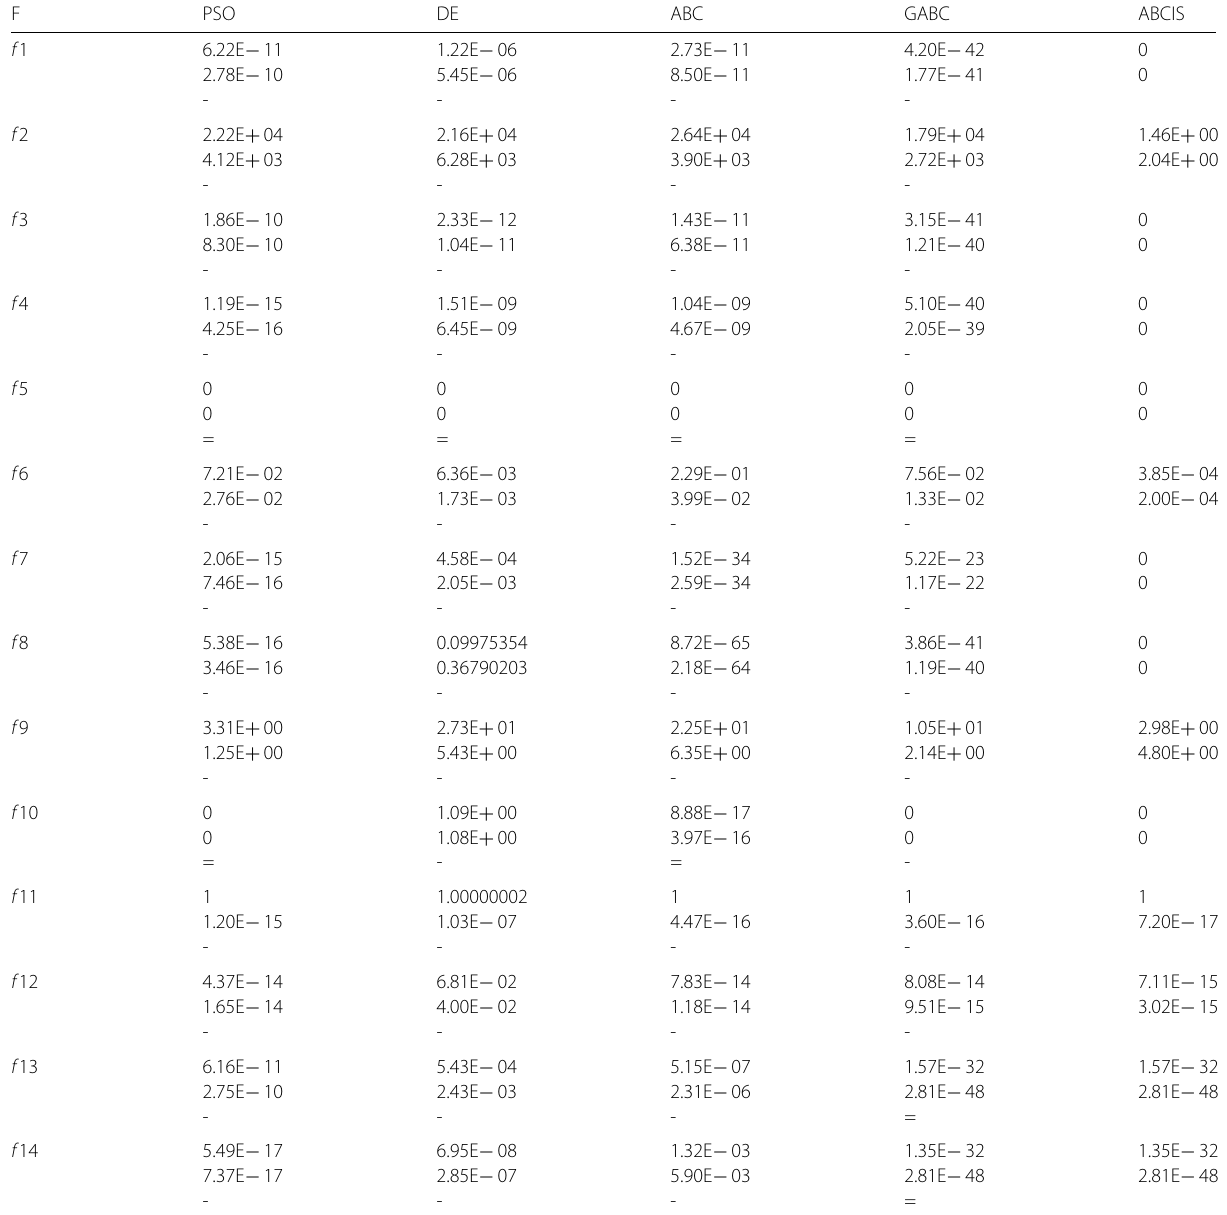
Table 4 Comparison results, D = 50 ( Continued